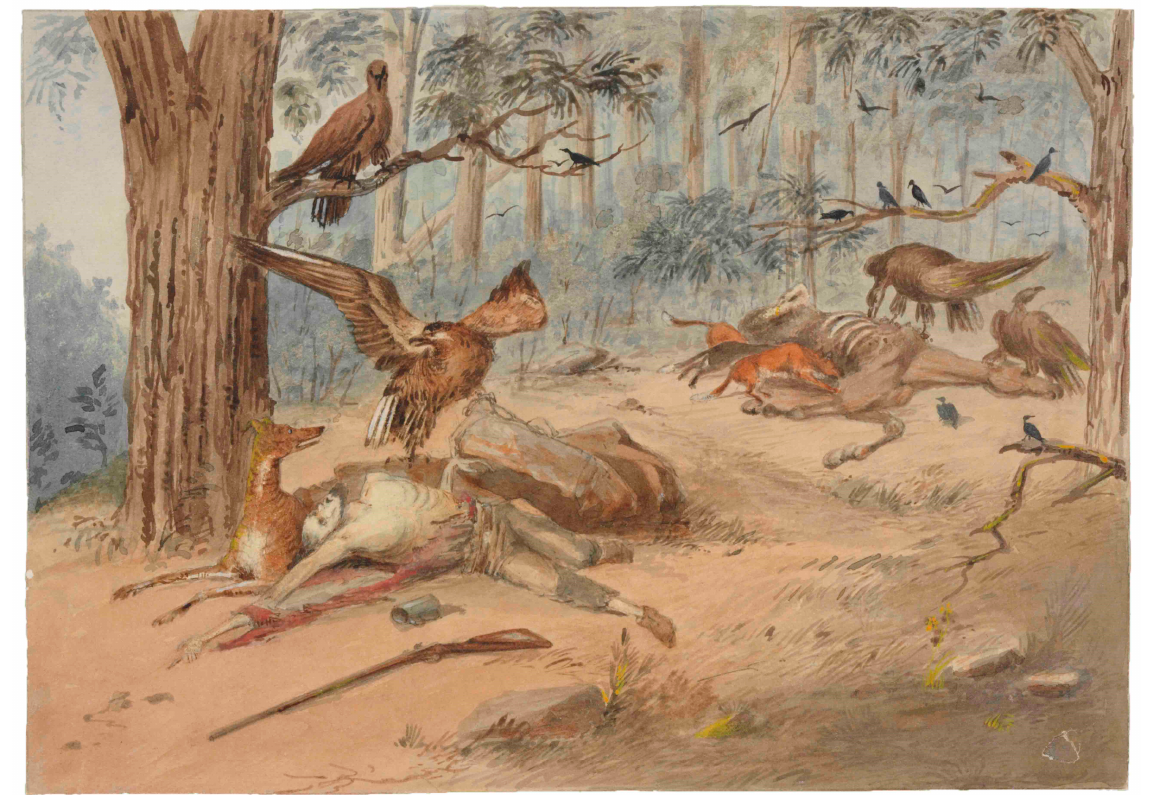
Figure A3. A depiction of dingoes scavenging the body of a man who died while lost in the Bush. Title: ‘“Lost in the Bush” close to the dividing Ranges between N.S. Wales. A sketch taken on the spot by J. F. Doyle’; Dr Doyle’s sketch book, ca. 1862–1863/John Thomas Doyle & Samuel Thomas Gill (PXA 1983). Reproduced with permission of the State Library of New South Wales.